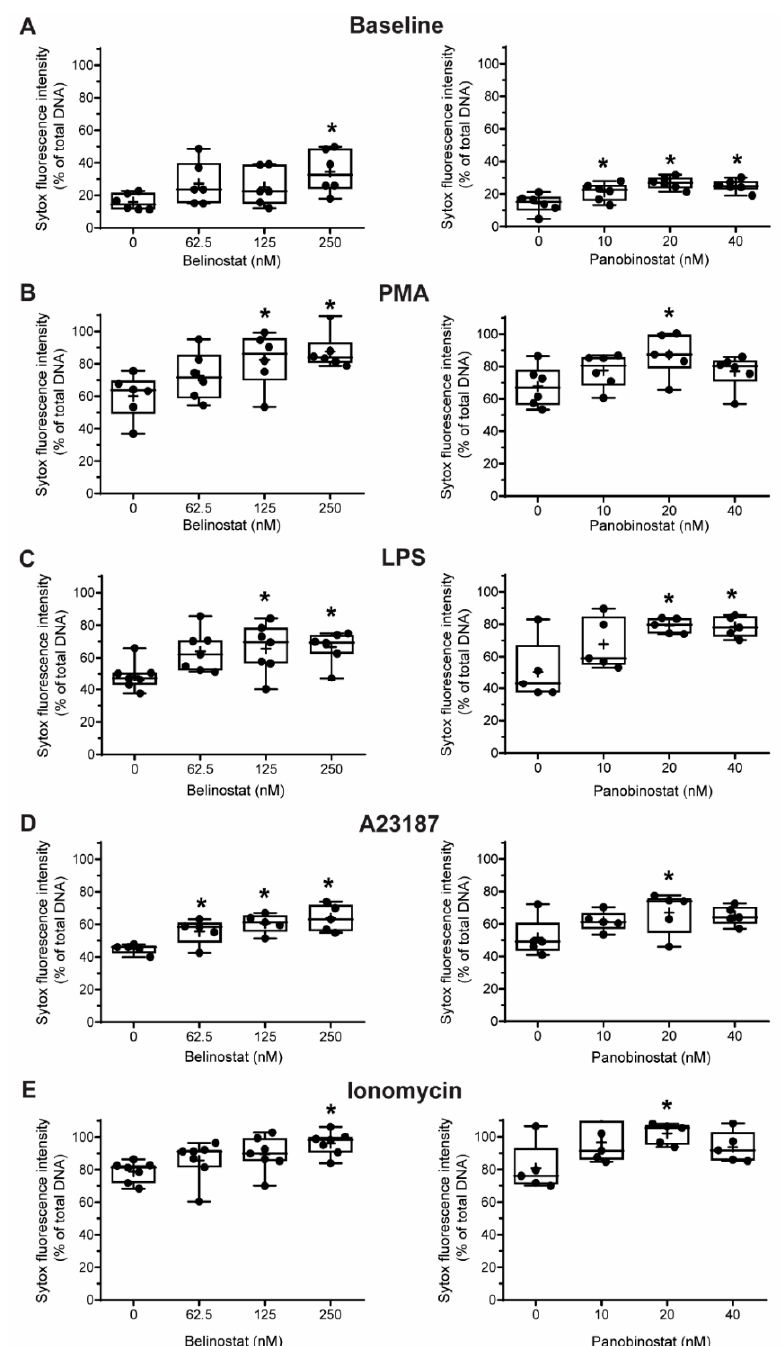
Figure 3. Sytox Green assays suggest that belinostat and panobinostat promote baseline NETosis as well as both NOX-dependent and -independent NETosis. Neutrophils were treated with HDACis and/or NETotic agonists and Sytox Green fluorescence intensities were then measured at 4 h by using a fluorescence plate reader. ( A ) Effects of belinostat and panobinostat on baseline NETosis. ( B , C ) Neutrophils were activated with PMA ( B ) or LPS ( C ) in the presence or absence of belinostat or panobinostat. ( D , E ) Neutrophils were activated with A23187 ( D ) or ionomycin ( E ) in the presence or absence of belinostat or panobinostat. The full data spread is indicated with lines and boxes are marked with the mean (+), median and upper and lower interquartile ranges. * p < 0.05 (One-Way ANOVA with Dunnett post-test, n = 5–7). See Supplementary Figure S5 for additional information.